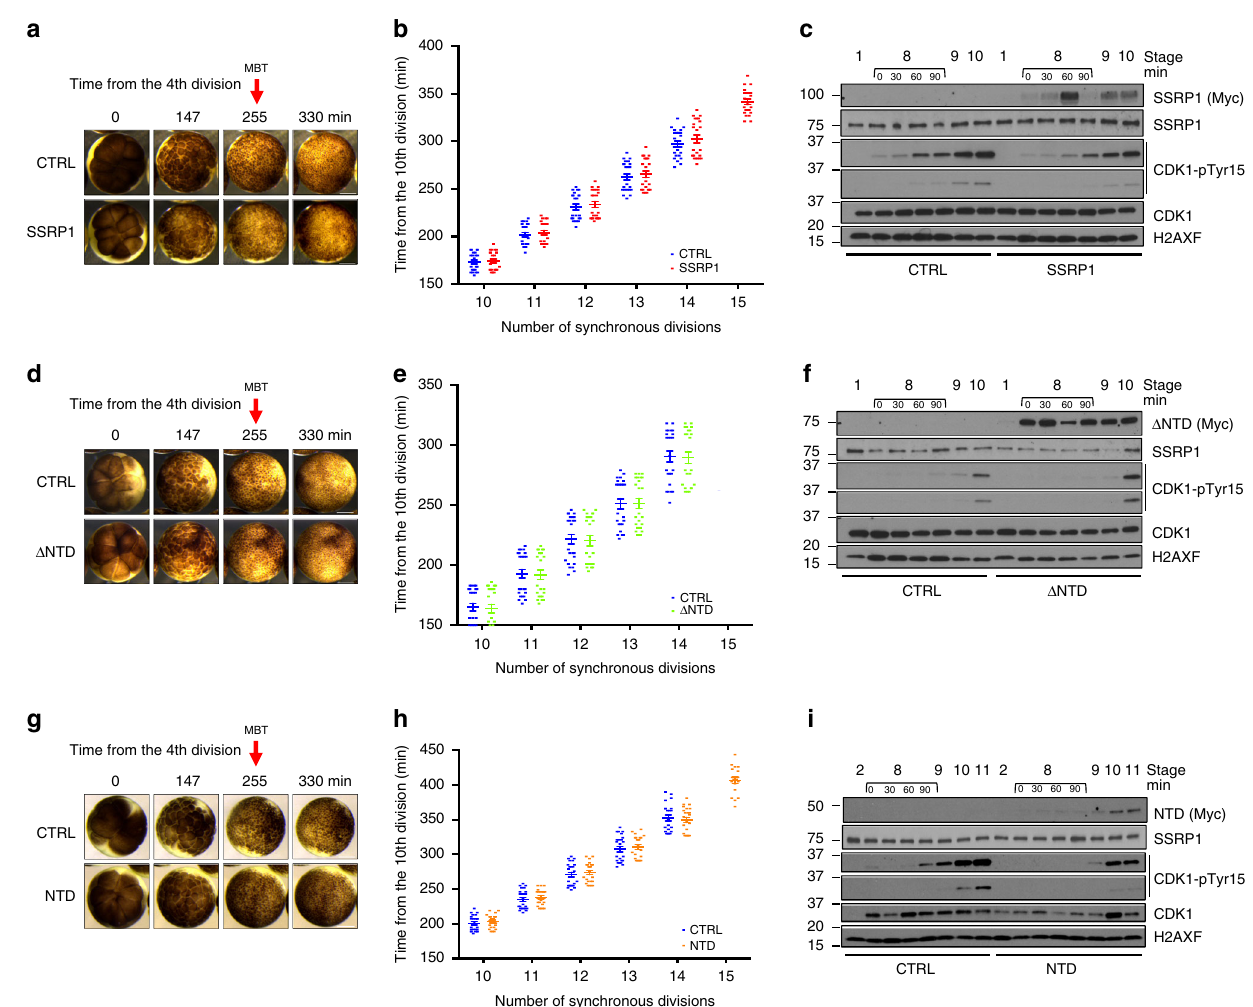
Fig. 6 SSRP1 induced delay of MBT onset. a Time lapse video frames taken from movie S1 at the indicated times from the 4th cleavage (set as time zero) of embryos injected at the one-cell stage. Top row: control buffer (CTRL) injected embryos; Bottom row: embryos injected with Myc-SSRP1 mRNA. Size bar = 500 μ m. b Graph showing the number of synchronous divisions-only of 24 embryos injected with Myc-SSRP1 mRNA or buffer and monitored up to 450 min from fertilization. Only cleavages after the 10th are shown to simplify graph layout. Each dot represents one embryo. Bars show mean ± SEM. c WB using the indicated antibodies of whole embryos injected with Myc-SSRP1 mRNA or buffer and taken at the indicated stages. Stage 8 was sampled every 30 min. d Images taken as in ( a ) from time-lapse movie S2. Embryos injected with control buffer or Myc- Δ NTD mRNA. Size bar = 500 μ m. e Graph showing the number of synchronous divisions monitored as in ( b ) of embryos injected with buffer or Myc- Δ NTD mRNA. f WB of whole embryos injected with Myc- Δ NTD mRNA or buffer and taken as in ( c ). g Images taken as in ( a ) from time-lapse movie S3 of embryos injected with control buffer or NTD mRNA. Size bar = 500 μ m. h Graph showing the number of synchronous divisions monitored as in ( b ) of embryos injected with control buffer or Myc-NTD mRNA. i WB of whole embryos injected with control buffer or Myc-NTD mRNA taken as in ( c